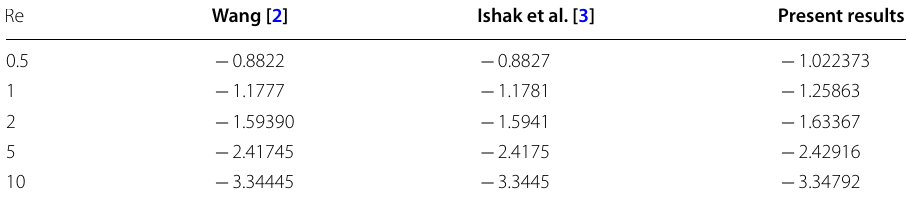
0.7 (for pure water) =